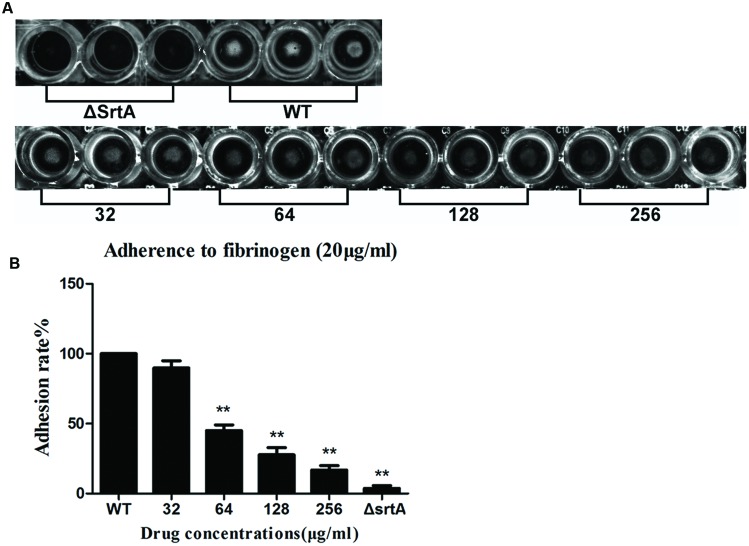
Fibrinogen (Fg)-binding assays. The value of the ΔSrtA as the ideal sortase inhibitor was used as a positive control. (A) The results could be inspected directly. (B) Adhesion rate of bacterial cells to Fg. CHA reduced the adhere of WT to Fg in a dose dependent manner. Each result was derived from three independent experiments and presented as the mean ± SEM. ∗∗P < 0.01 vs. the WT group.